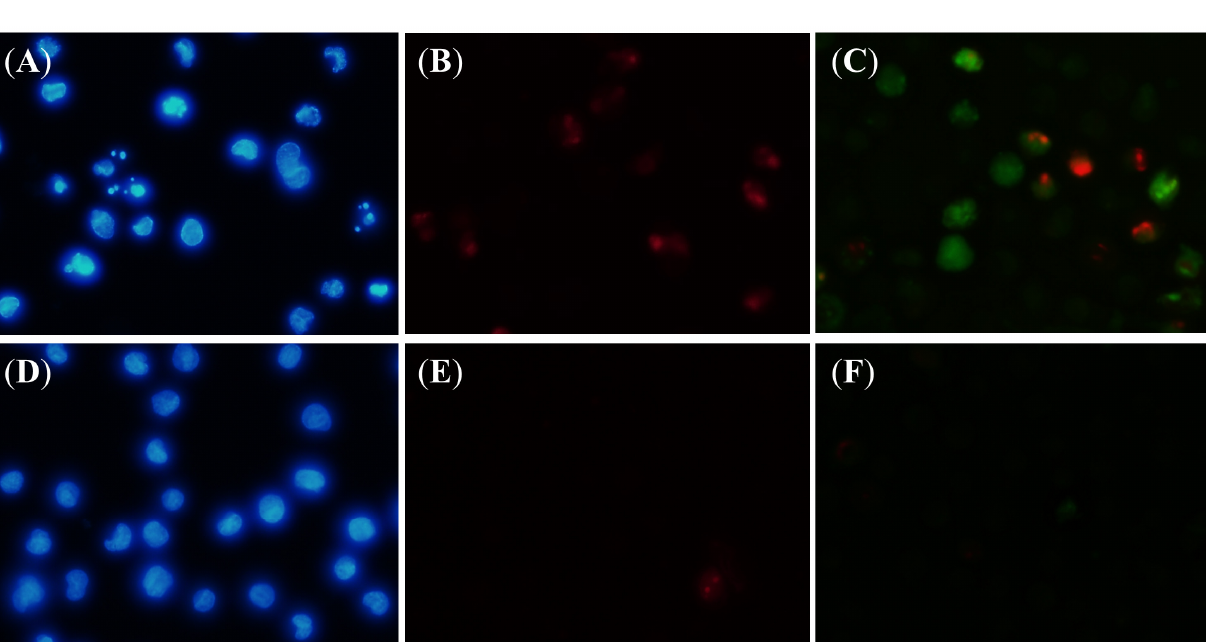
Figure 4. Chromatin condensation pattern in the HeLa cells treated with 50 µM cubelin ( A ) and in the untreated population ( D ) was revealed by using Hoechst 33342. Dead cells in the cubelin treated ( B ) and the untreated population ( E ) were revealed by PI. The presence of caspase-3/-7 was clearly evident in the cubelin treated cells ( C ), while that in the untreated population ( F ) was not